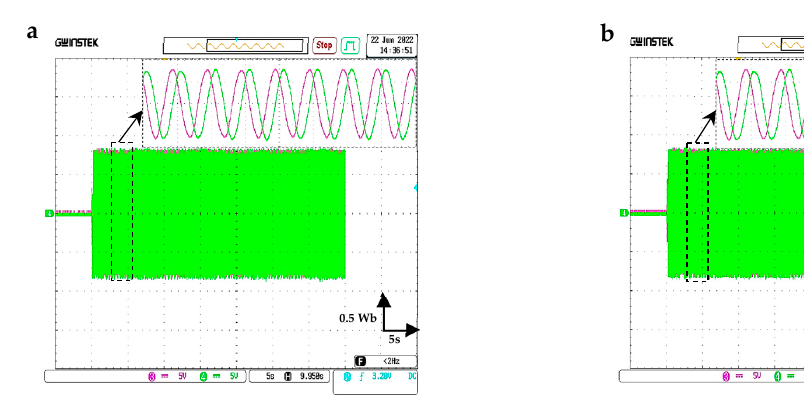
Figure 23. Rotor flux components for speed profile 1 and 2.